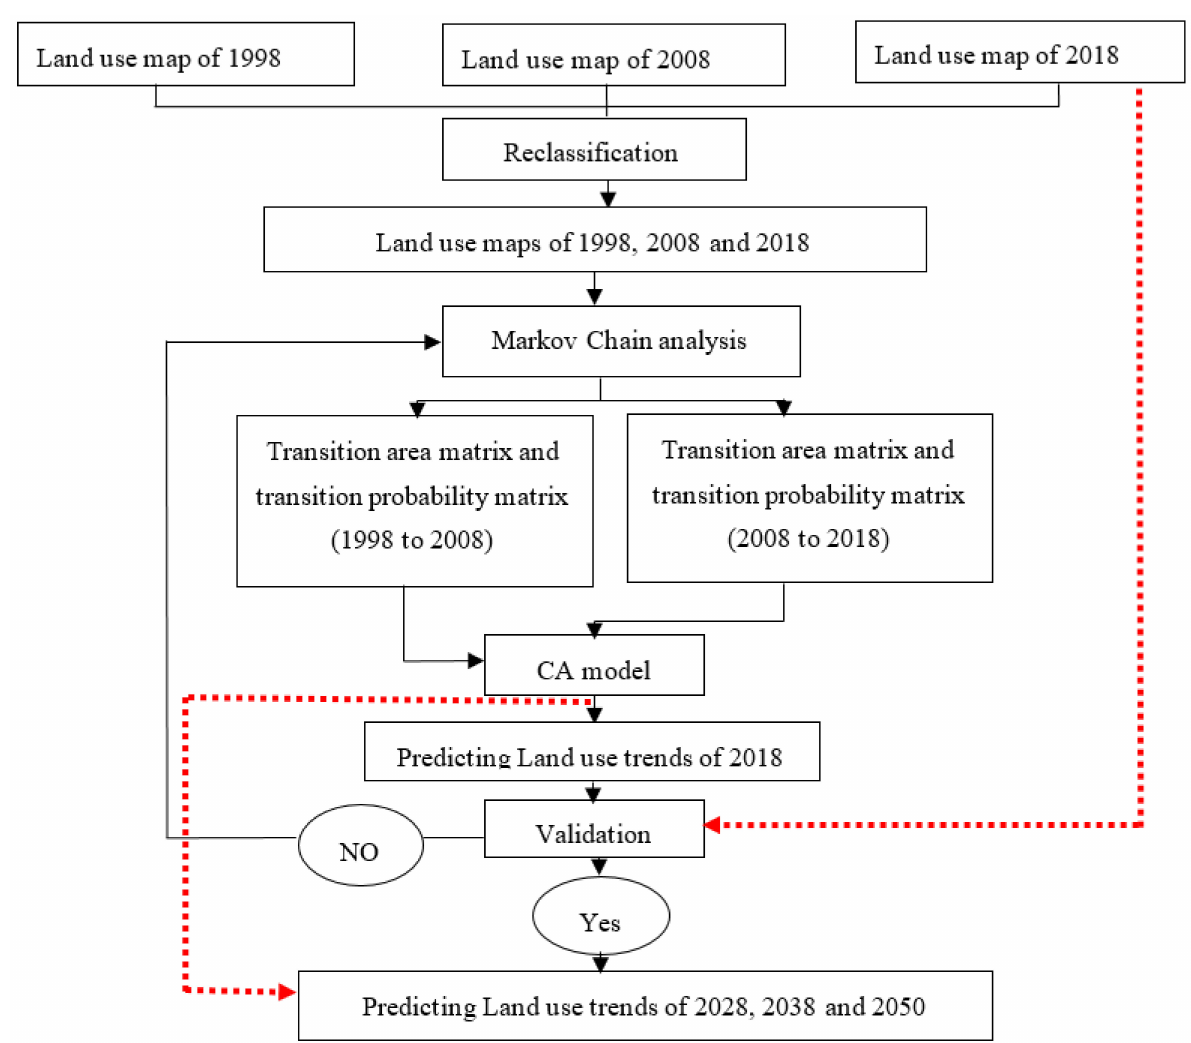
Figure 2. Methodological flowchart applied in the present